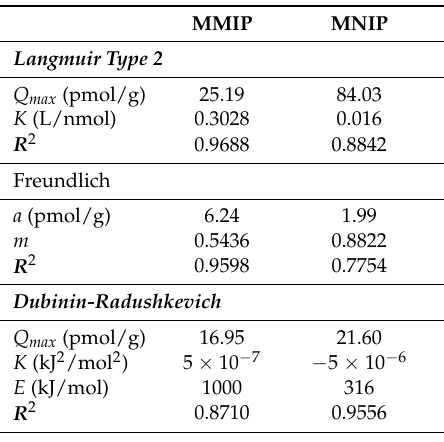
Table 2. Langmuir, Freundlich, and Dubinin-Radushkevich isotherm constants for the adsorption of IBMP on thermally synthesised magnetic